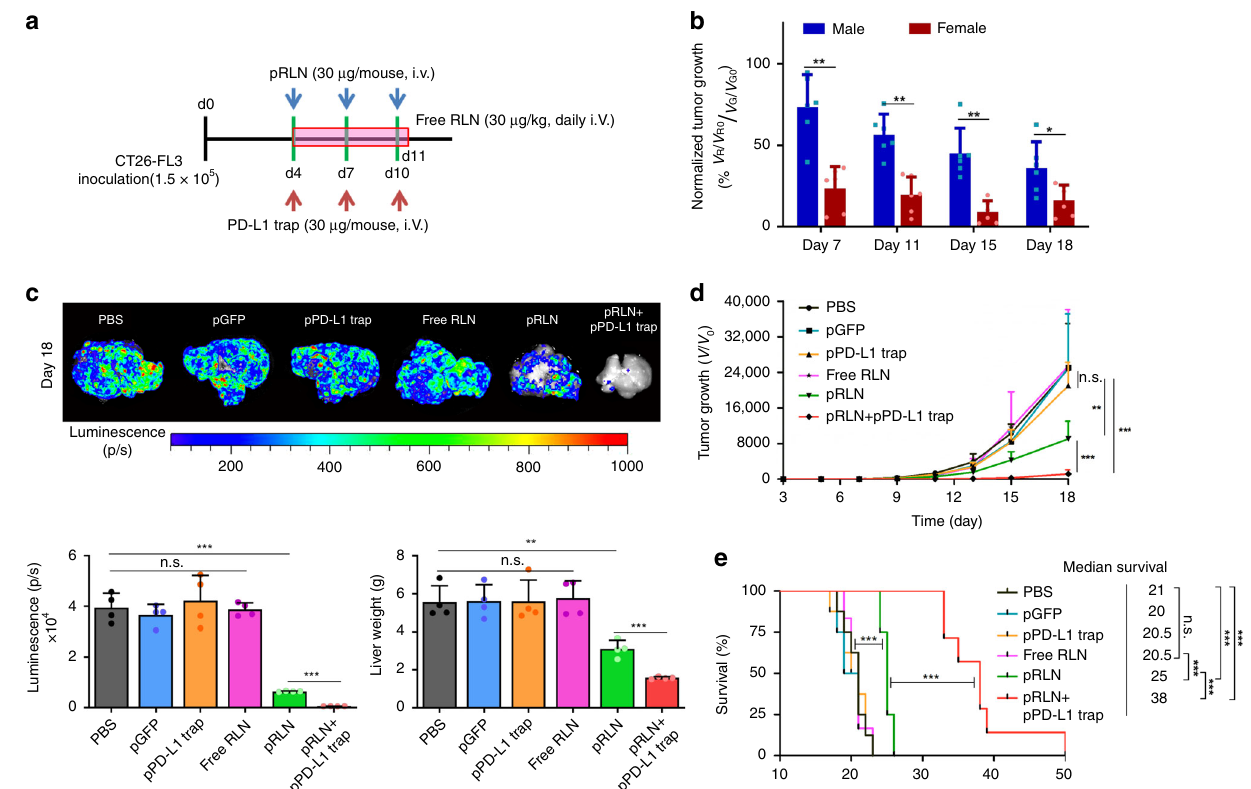
Fig. 4 RLN gene therapy shows gender-biased response and synergizes with PD-L1 blockade in CT26-FL3 liver metastasis. a Tumor inoculation and treatment scheme for pRLN LCP, free RLN, or pRLN + pPD-L1 trap LCP therapy. b Difference of normalized tumor growth rate between two genders after pRLN LCP treatment ( n = 6). The normalized tumor growth rate was calculated comparing the fold-changes over initial of the metastasis volume ( V / V 0) characterized by bioluminescence intensity in the pRLN LCP-treated group with those of the pGFP LCP group. V R , tumor volume after pRLN LCP treatment; V V V R0 , initial tumor volume of the pRLN LCP group; G , tumor volume after pGFP LCP treatment; G0 , initial tumor volume of the pGFP LCP group. c Imaging and quanti fi cation analysis (both bioluminescence and liver weight) of ex vivo CT26-FL3 liver metastasis burden from PBS, pGFP LCP, pPD-L1 trap LCP, free RLN, pRLN LCP, and pRLN + pPD-L1 LCP treated groups 18 days after tumor inoculation ( n = 4). d Metastatic growth curves of CT26-FL3 liver metastasis in each treatment group ( n = 8). e Mice survival curves in each treatment group ( n = 8). Signi fi cant differences were assessed in ( b ) using t test, in ( d ) using two-way ANOVA with multiple comparisons, in ( e ) using log rank test. Results are presented as mean (SD). * p < 0.05, ** p < 0.01, *** p < 0.001,